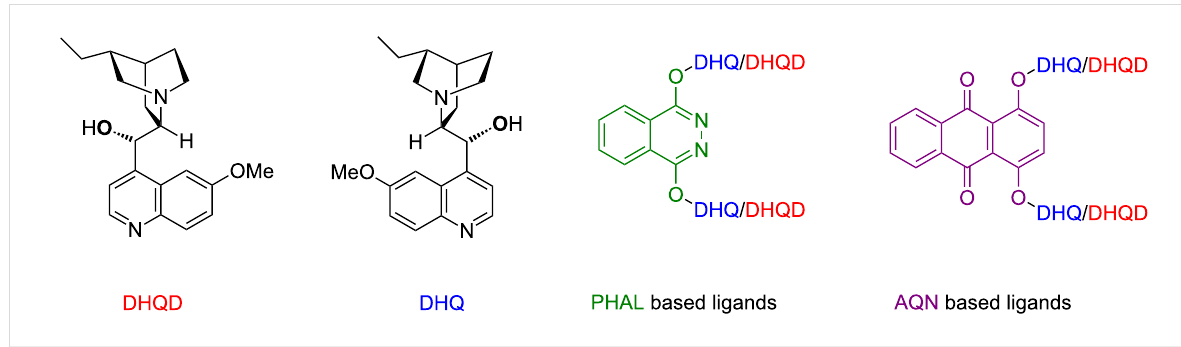
Figure 2: The ligand panel used in the asymmetric dihydroxylation studies. The bold oxygen shows the point of attachment; individual ligands are represented by combinations of components, for example (DHQD) 2 PHAL, present in AD-mix β .